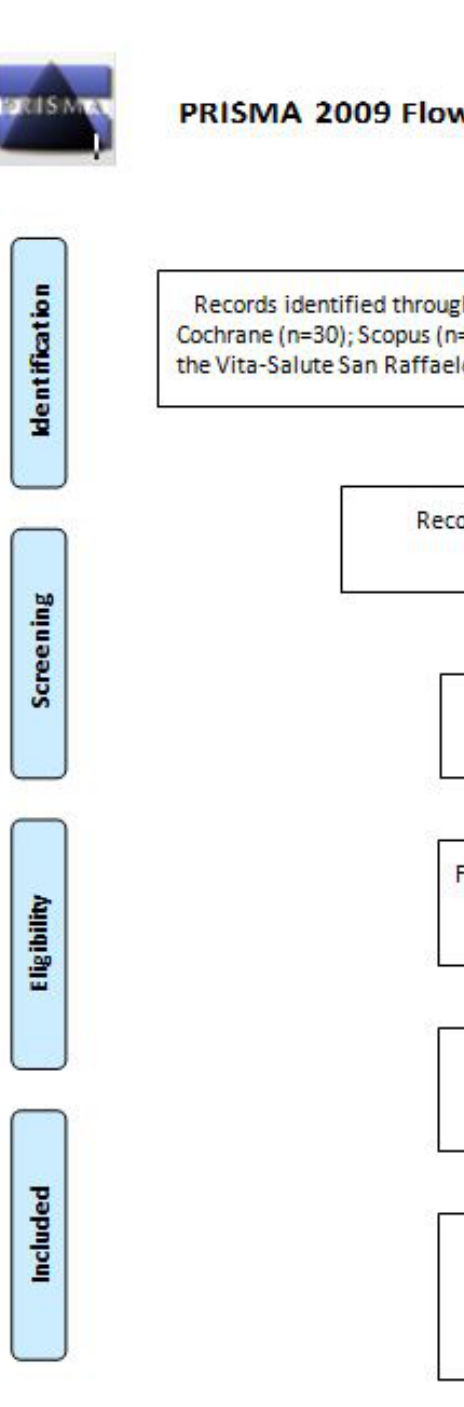
Figure 1. PRISMA flow diagram: screening and selection process.